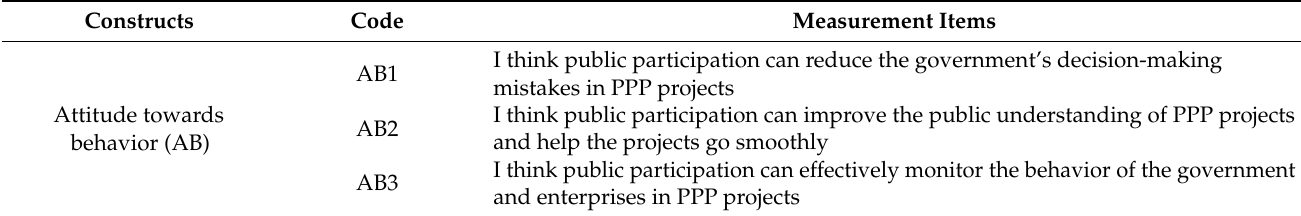
Table A1. Measurement Items in the Formal